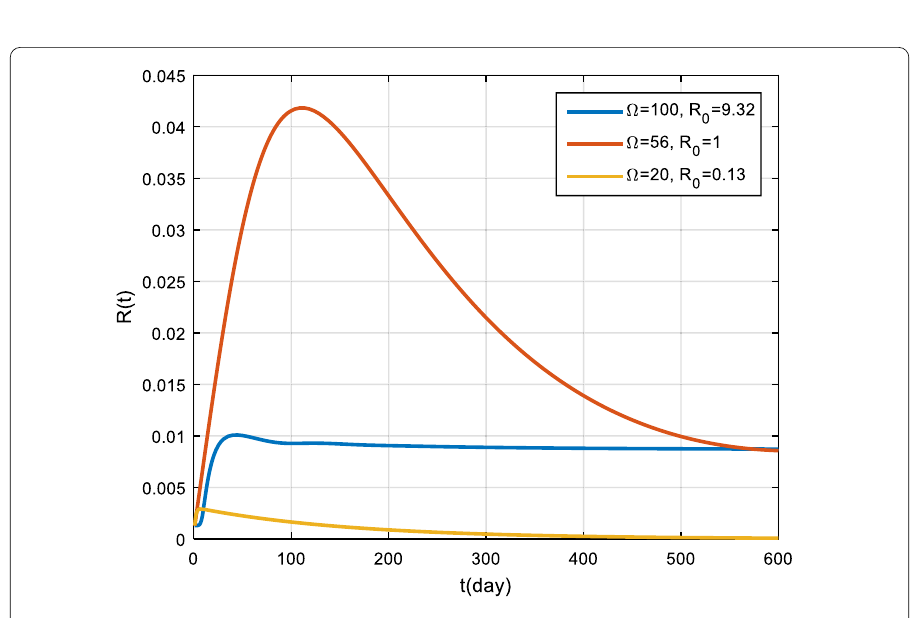
Figure 7 Variation in the number of recovered population for different values of (cid:7)